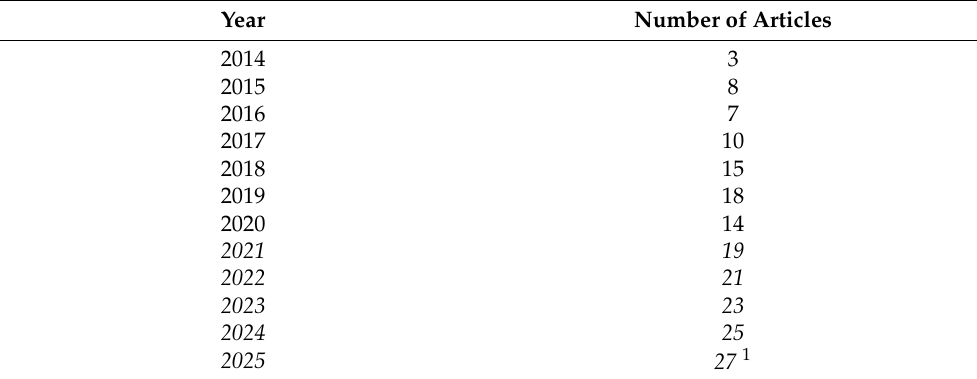
Table 6. Summary of the number of articles corresponding to the phrase “temporal big data” in the Scopus database in 2014–2020 along with the prediction of the number of articles in 2021–2025.